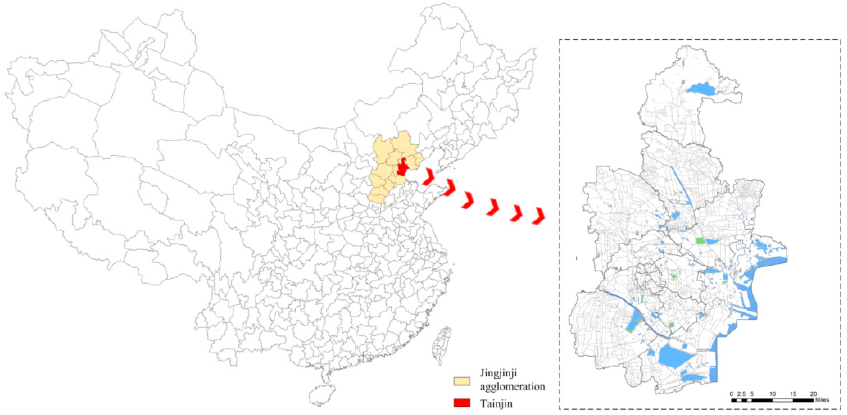
Figure 1. The administrative area of Tianjin in the Jingjinji agglomeration of China.